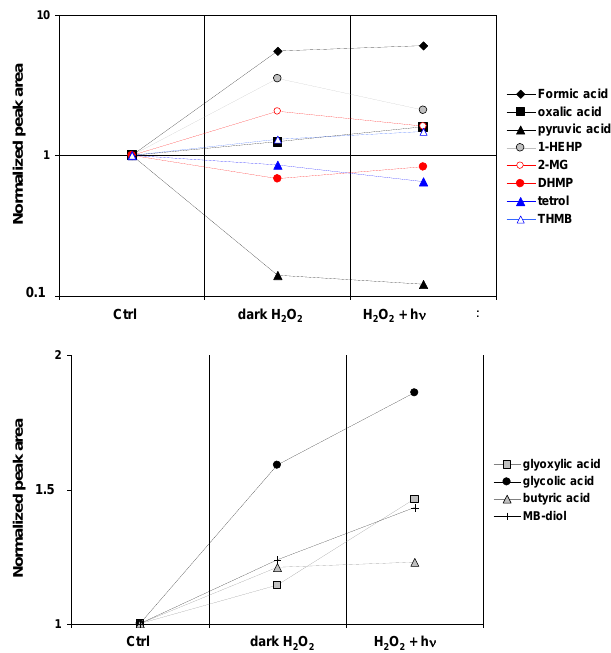
Fig. 7. Evolution of 12 identified and quantified reaction products from “control”, “dark H 2 O 2 ” to “H 2 O 2 + hν ” samples in the mass range 60 – 120 Da (experiment 2). All peak areas were normalized to “control” samples. 1-HEHP = 1-hydroxyethylhydroperoxyde; 2-MG = 2,3-dihydroxy-methacrylic acid (often called 2-methylglyceric acid); DHMP = 2,3-dihydroxy-2-methyl-propanal; Tetrol = 2-methylbutane-1,2,3,4-tetrol; THMB = Trihydroxy-3-methylbutanal; MB-diol = 2-methylbut-3-ene-1,2-diol. Quantification was performed using the conditions indicated in Table 1 where the corresponding chemical structures are indicated.